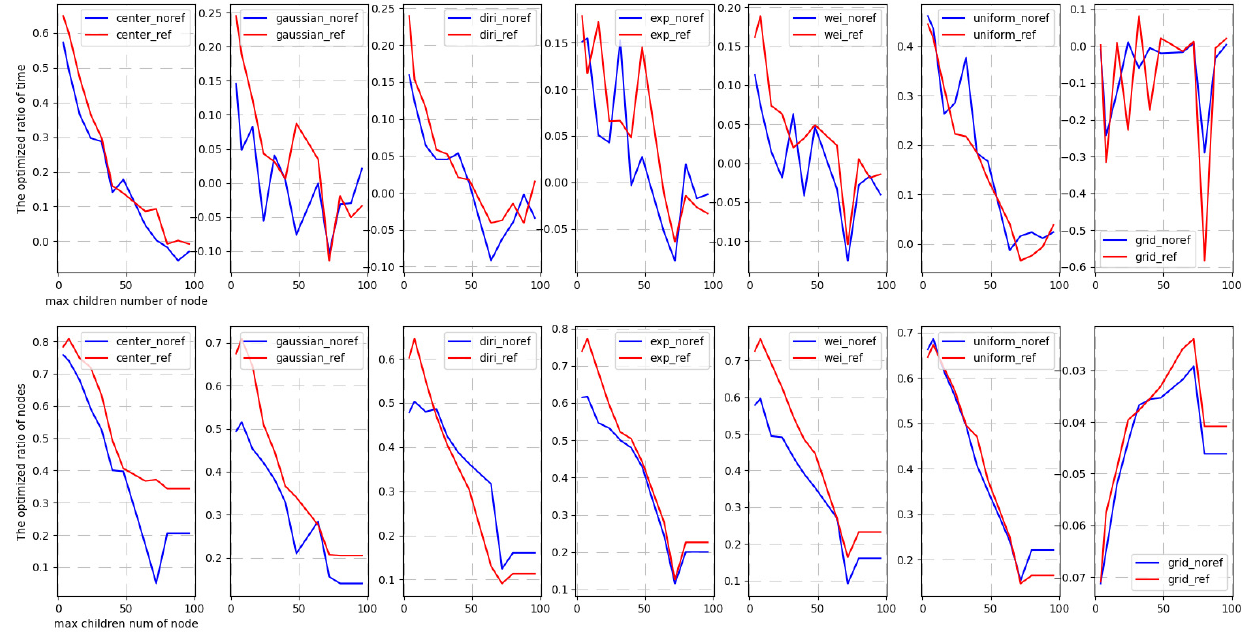
Figure 10. Query performance of the two algorithms under different query